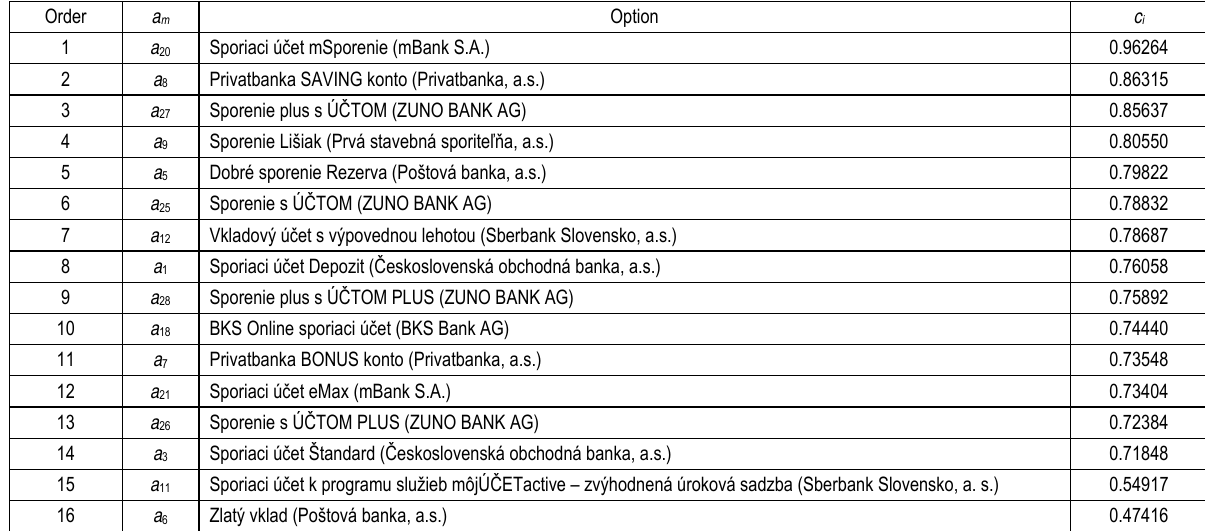
Table 8. Final arrangement of savings accounts according to chosen